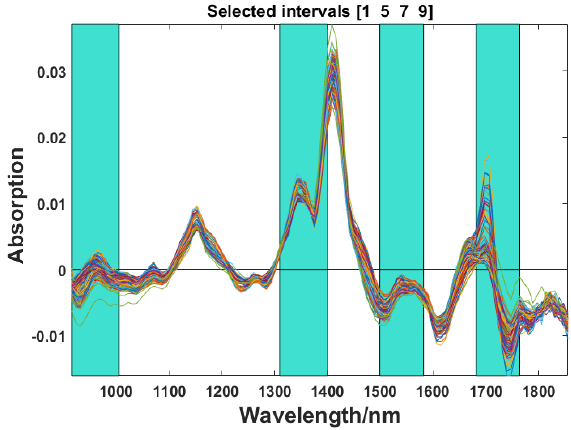
Figure 5. Optimal spectra intervals selected by SiPLS.